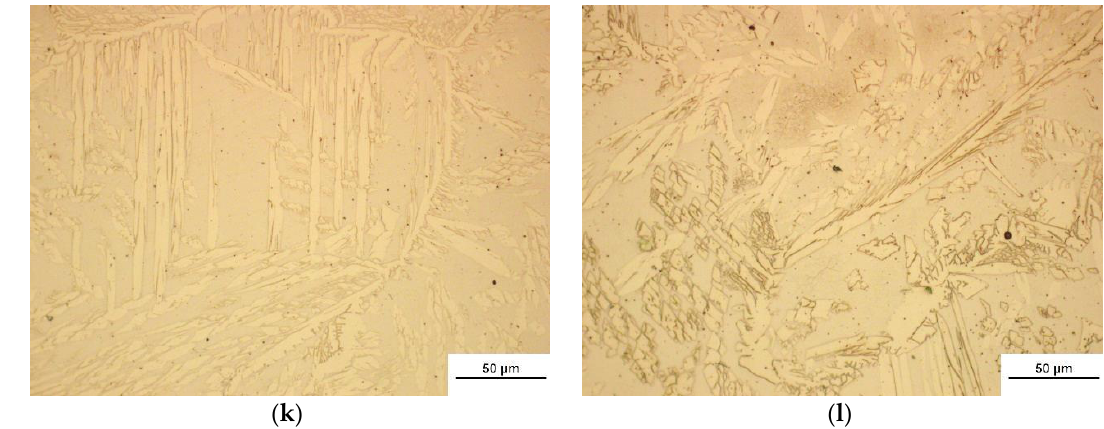
Figure 5. Metallographic test results: ( a ) Metallographic image of HAZ in Sample 1, ( b ) Metallographic image of HAZ in Sample 2, ( c ) Metallographic image of HAZ in Sample 3, ( d ) Metallographic image of HAZ in Sample 4, ( e ) Metallographic image of HAZ in Sample 5, ( f ) Metallographic image of HAZ in Sample 6, ( g ) Metallographic image of fusion zone in Sample 1, ( h ) Metallographic image of fusion zone of in Sample 2, ( i ) Metallographic image of fusion zone in Sample 3, ( j ) Metallographic image of fusion zone in Sample 4, ( k ) Metallographic image of fusion zone in Sample 5, ( l ) Metallographic image of fusion zone in Sample 6.